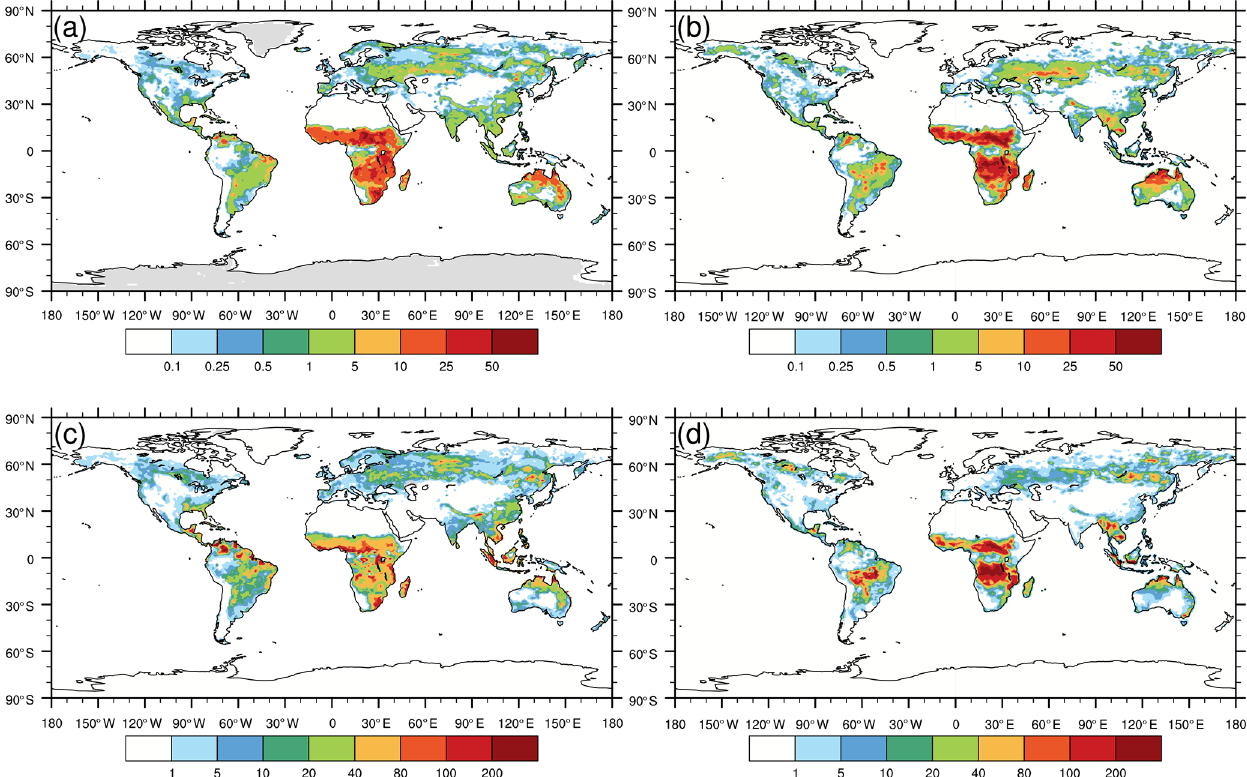
Figure 6. Comparison of CESM-RESFire simulations and GFED4.1s data. (a) Ensemble-averaged annual fractional burned area (%yr − 1 ) simulation; (b) 10-year averaged (2001–2010) annual fractional burned area (%yr − 1 ) based on the GFED4.1s data; (c) ensemble-averaged annual fire carbon emission (gCm − 2 yr − 1 ) simulation; (d) 10-year averaged (2001–2010) annual fire carbon emission (gCm − 2 yr − 1 ) based on the GFED4.1s data. Table 4. Comparison of carbon budget variables between fire simulations driven by the CRUNCEP data atmosphere based on CESM-RESFire and CLM-LL2013. Variables CESM-RESFire CLM-LL2013 (Li et al., 2014) Unit: PgCyr − 1 (cid:49) Fire Fire on Fire off (cid:49) Fire Fire